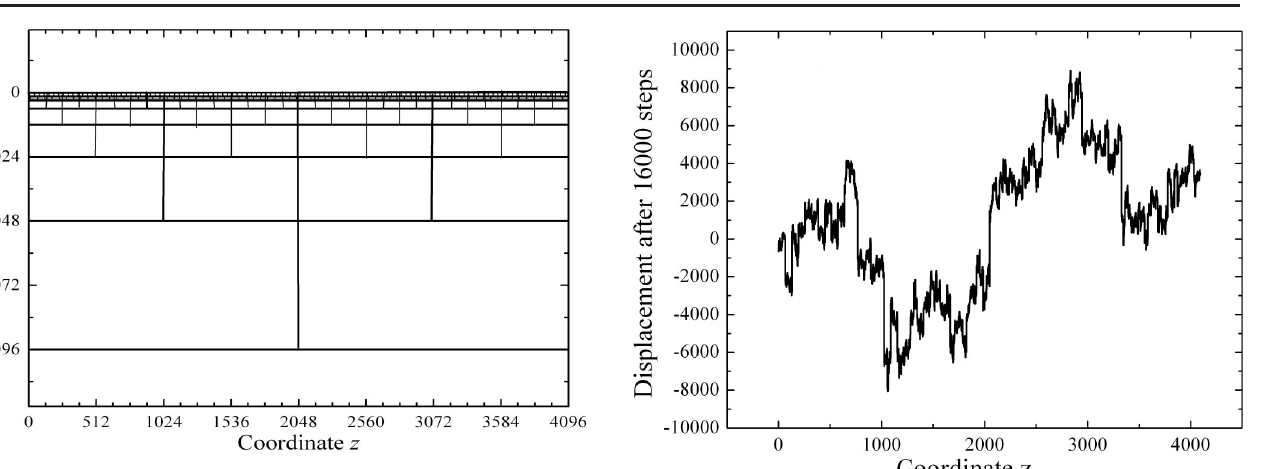
FIG. 45. Elevations of the set points after 16 000 steps with parameters of the model (cid:4) ¼ (cid:7) ¼ 1 . Coordinate z is given in the units of the minimal block